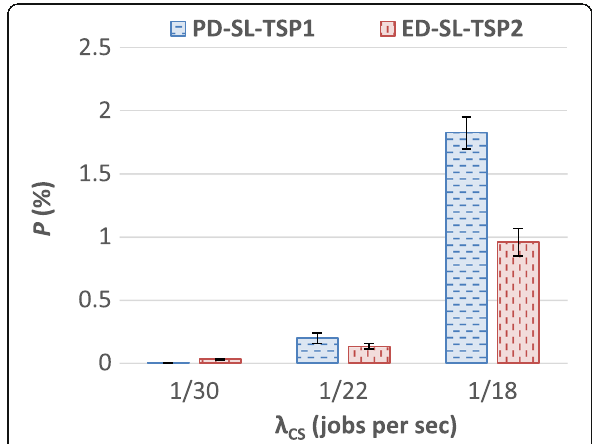
Fig. 6 Effect of λ CS on P when using the CyberShake workload